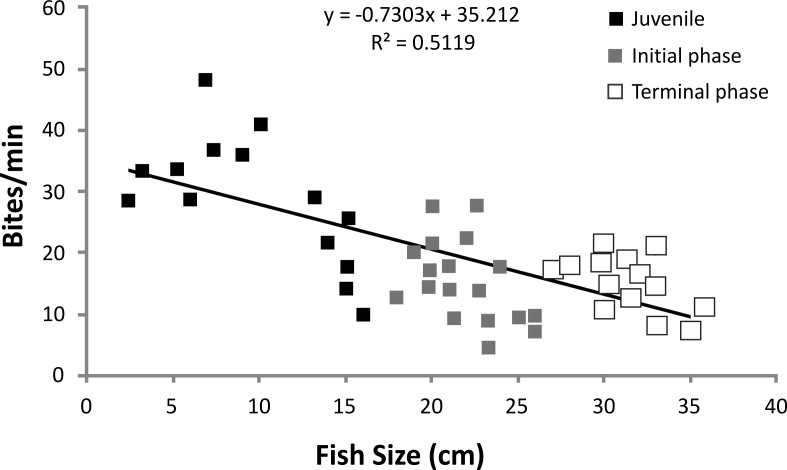
Linear regression of S. zelindae feeding rates (bites/min−1) compared with fish size (cm).Each point represents an individual. Size of S. zelindae ranged from 2.5 cm to 36 cm.